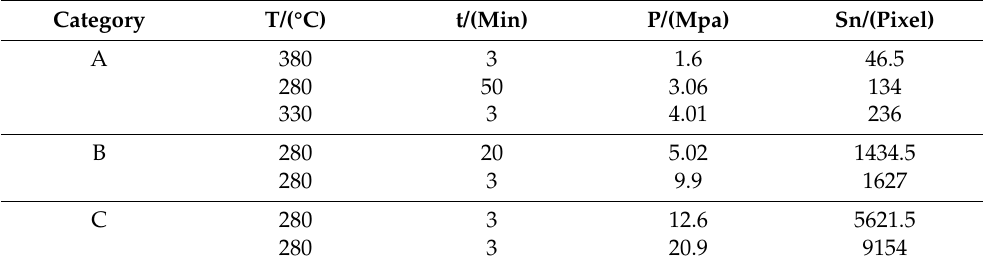
Figure 4. Schematic diagram of the wafer fracture form and comparison between A, B, and C. ( a ) The image of original in category A, ( b ) the image of the procession in category A, ( c ) the image of canny edge detection in category A, ( d ) the image of original in category B, ( e ) the image of the procession in category B, ( f ) the image of canny edge detection in category B, ( g ) the image of original in category C, ( h ) the image of the procession in category C, and ( i ) the image of canny edge detection in category C. Table 4. Comparison of the bonding temperature (T), bonding time (t), bonding strength (P), and the Table 2. Comparative results for the CNN and ResNet models. area of Sn on the wafer surface